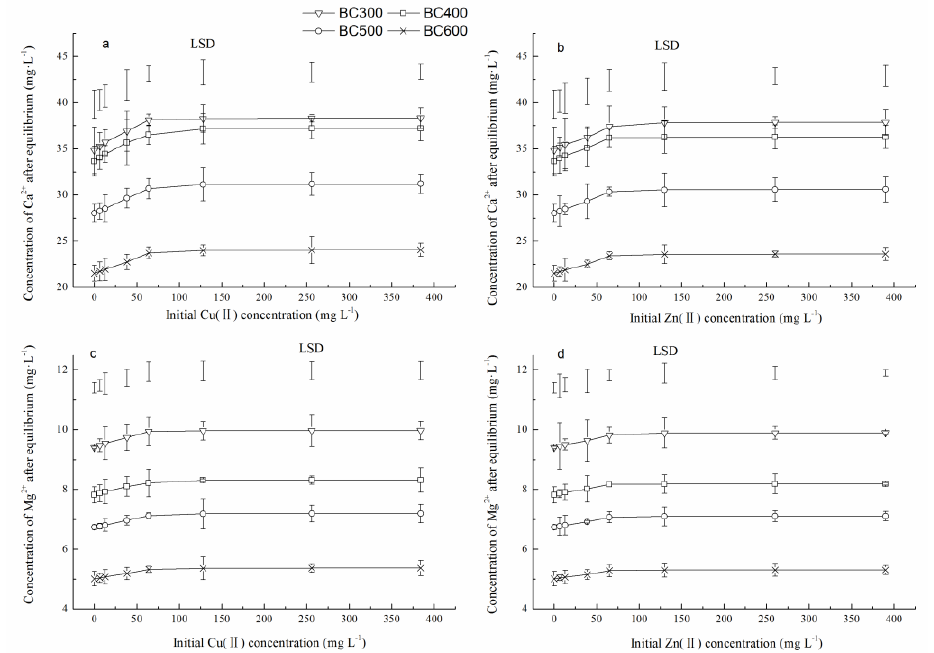
Figure 9. Variation of Ca 2+ and Mg 2+ during the absorption of Cu(II) ( a , c ) and Zn(II) ( b , d ) by BCs produced at different temperatures (reaction temperature 25 °C; BC dosage 5 g·L −1 ; initial solution pH 5.0; contact time 1440 min). Error bars represent standard error ( n = 3). LSD is the least significant difference at p < 0.05 under the same initial heavy metal concentration.